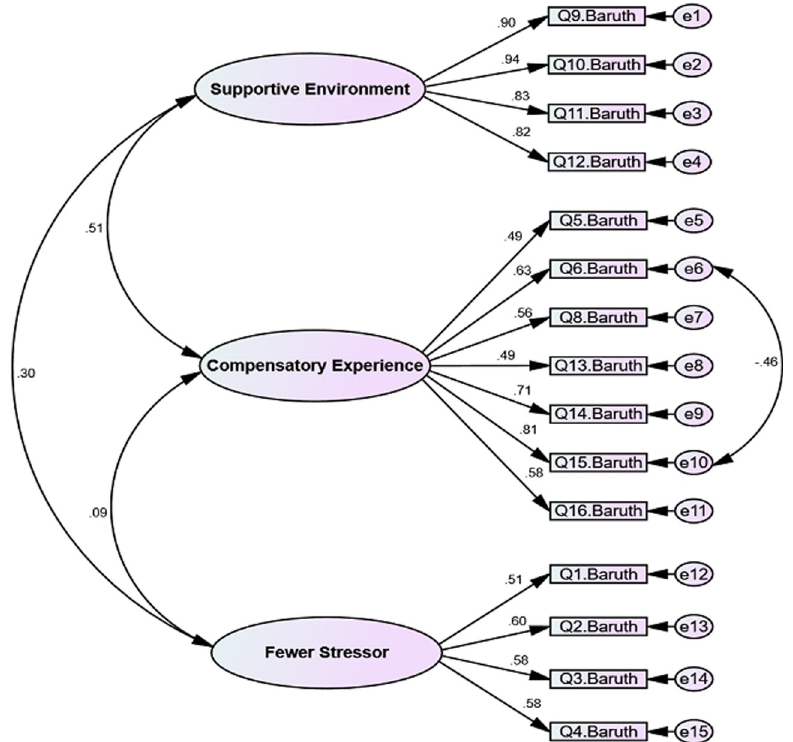
Fig 1. Final model of the first order CFA of the BPF1.